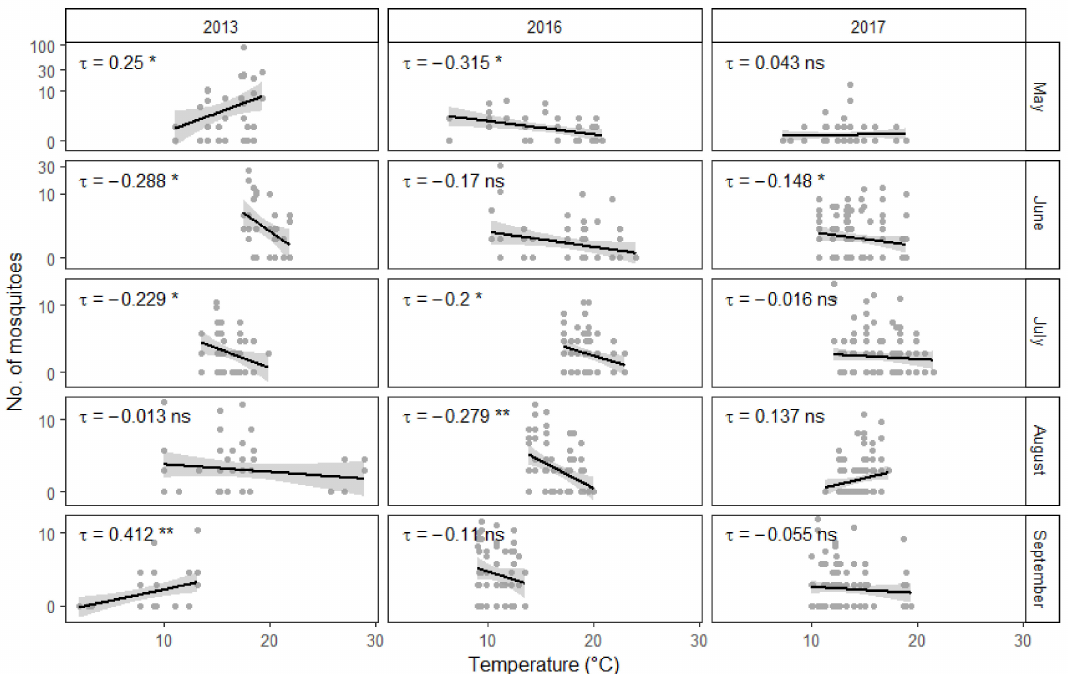
Figure 3. Influence of temperature on the abundance of mosquitoes during different months. Y-axis has been transformed to a logarithmic scale for ease of viewing. Gray points represent fieldwork results. Linear regression lines are surrounded by gray areas representing 95% confidence intervals. Correlation statistics have been calculated using the non-parametric Kendall rank correlation. Significance: >0.05 = “ns”, 0.05 to 0.01 = “*”, 0.01 to 0.001 = “**”.